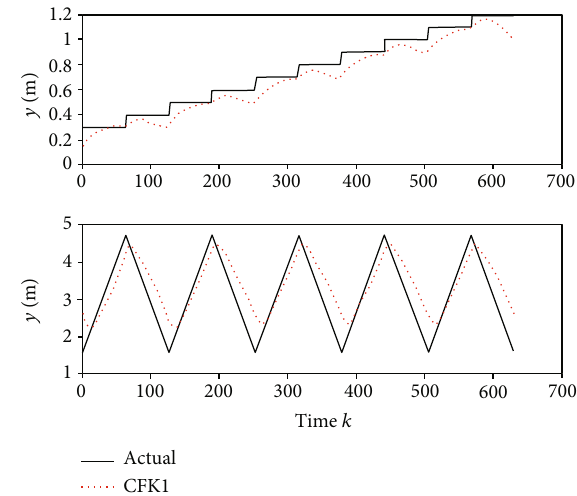
Figure 3: State estimation results after optimization of stochastic disturbance state estimation.